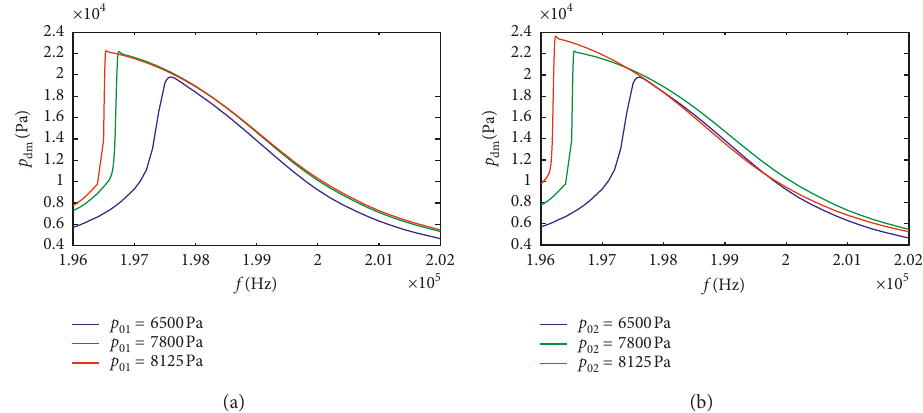
Figure 4: Maximum difference-frequency pressure amplitude in the cavity p f � 6 . 5 kPa and three values of p ) for (a) p 2 02